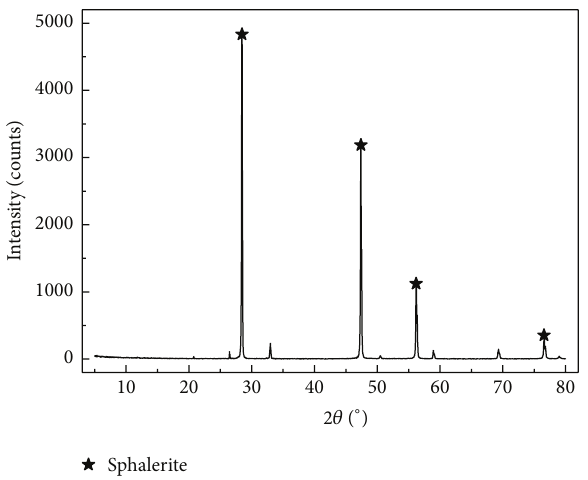
Figure 1: XRD pattern of the sphalerite sample.